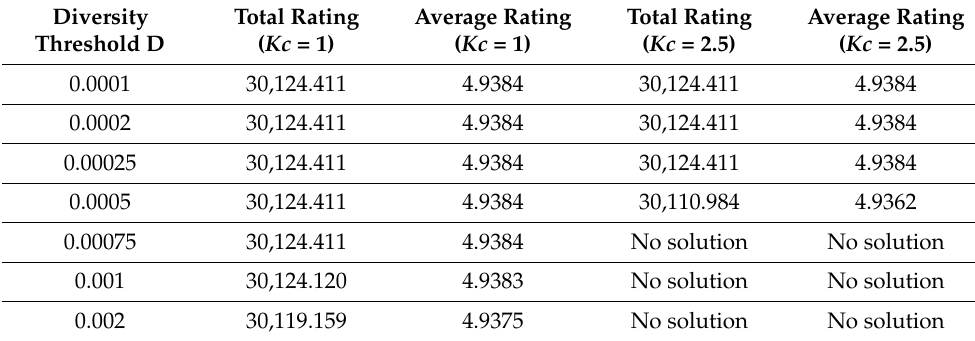
Table 2. Average and total rating for different values of diversity and coverage.